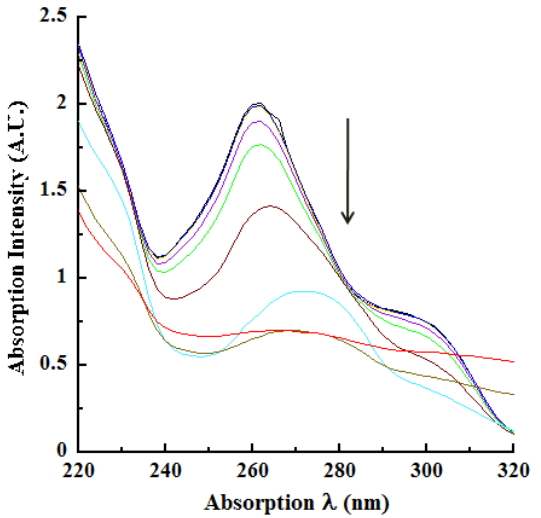
Figure 3B. Laccase oxidation of CA at 57 minutes. Laccase-catalyzed oxidation of CA was monitored at 57 minutes in kinetic mode. All other conditions are as described in the legend to Figure 3A. The nine tracings representing the reactions in the absence of enzyme (0 μ g/mL; black tracing) and the eight concentrations of laccase listed in Figure 3A (indicated by the downward pointing arrow) are better distinguished in Figure 3B due to the reaction